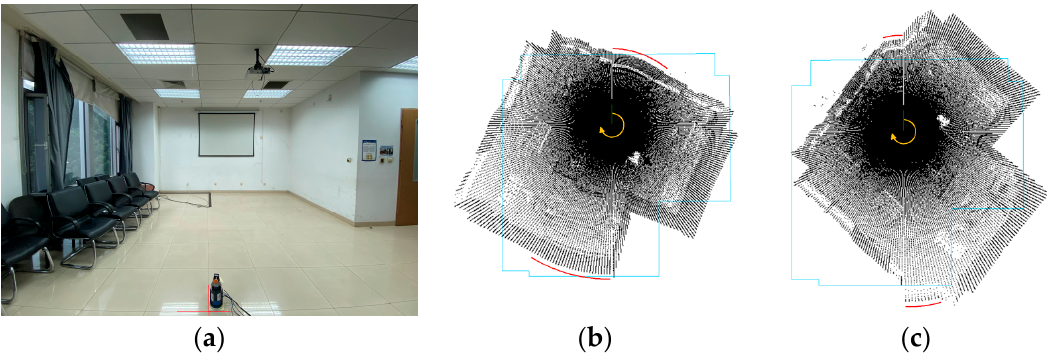
Figure 1. The shape error and attitude error of the 3D point cloud: ( a ) a photo of the environment for collecting the 3D point cloud; ( b ) top view of a 3D point cloud collected by a rotating 2D lidar; ( c ) top view of another 3D point cloud collected by a rotating 2D lidar.